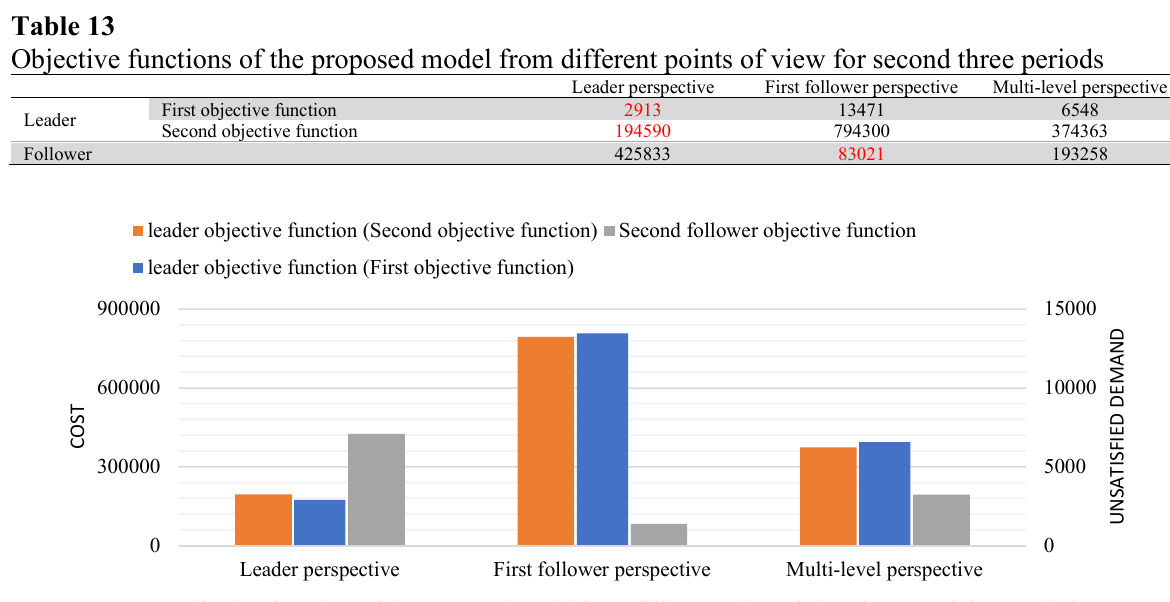
Fig. 5. objective functions of the proposed model from different points of view for second three